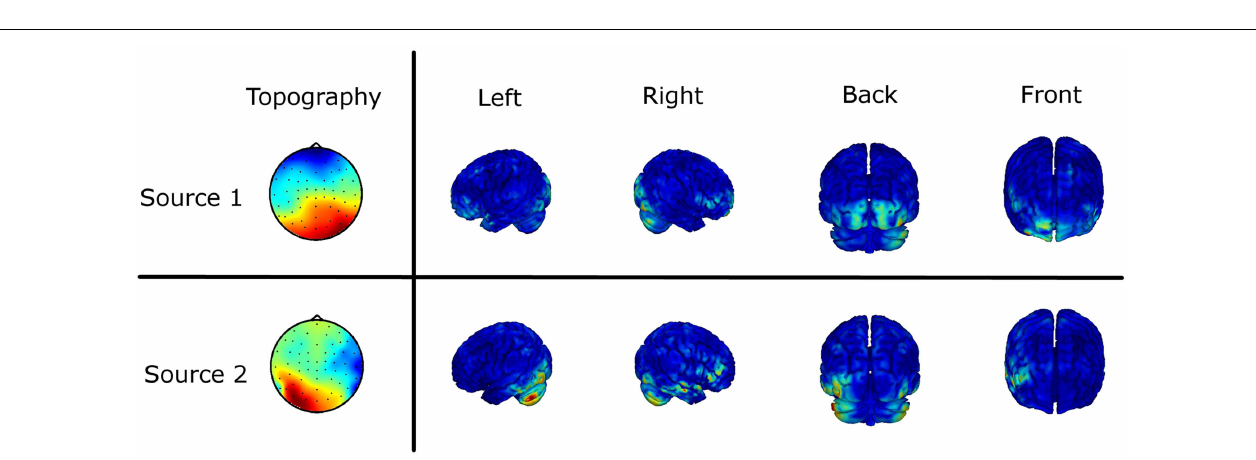
FIGURE 6 | Source localization of the main interaction of the difference in the two experimental conditions based on the imaginary part of the cross-spectrum. The two topographies (TopoView) are the eigenvectors of